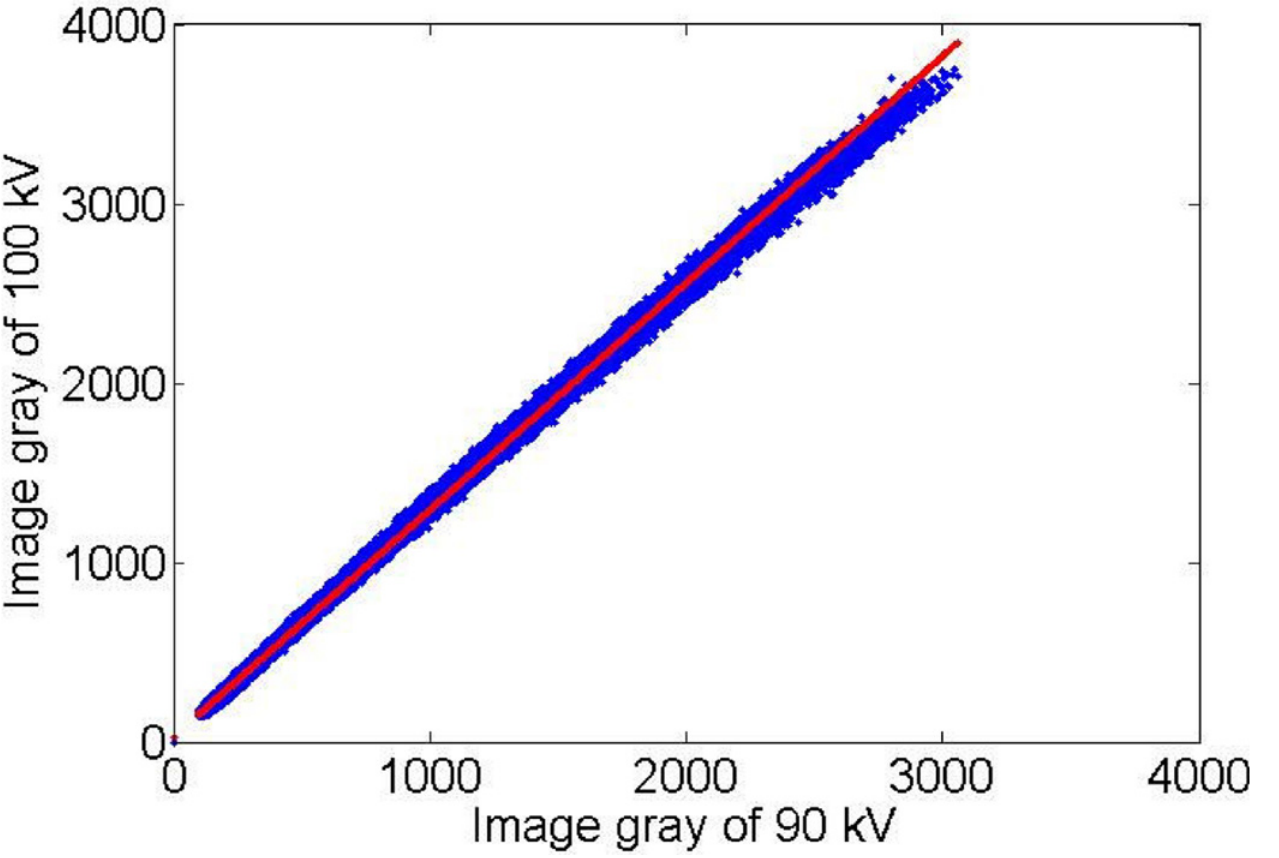
Fig 7. The processed gray figure about 90kV and 100kV. That has excluded the non-interesting area (overexposed area and “ strip-like ” noise).